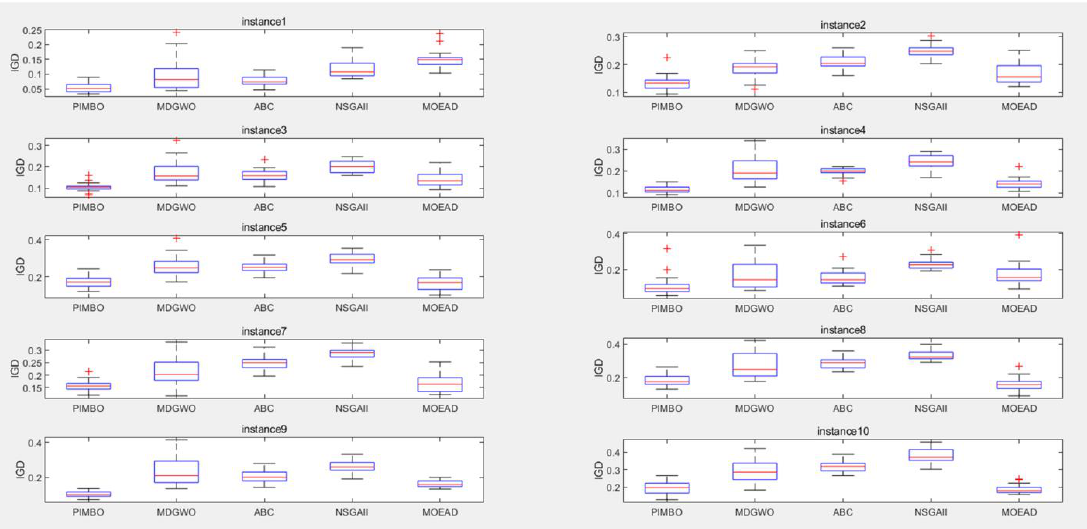
Figure A8. Boxplot of the experimental results of five algorithms via IGD metric.